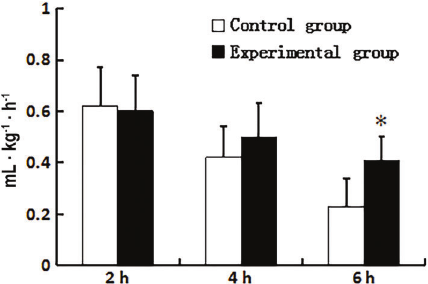
Figure 2. Urine volume per hour in male pigs induced with acute respiratory distress syndrome that received continuous veno- venous hemo fi ltration therapy (experimental) or conventional supportive therapy (control). The urine volume per hour in the experimental group was signi fi cantly higher than in the control group at 6 h (*P o 0.05, t -test). Data are reported as means ±